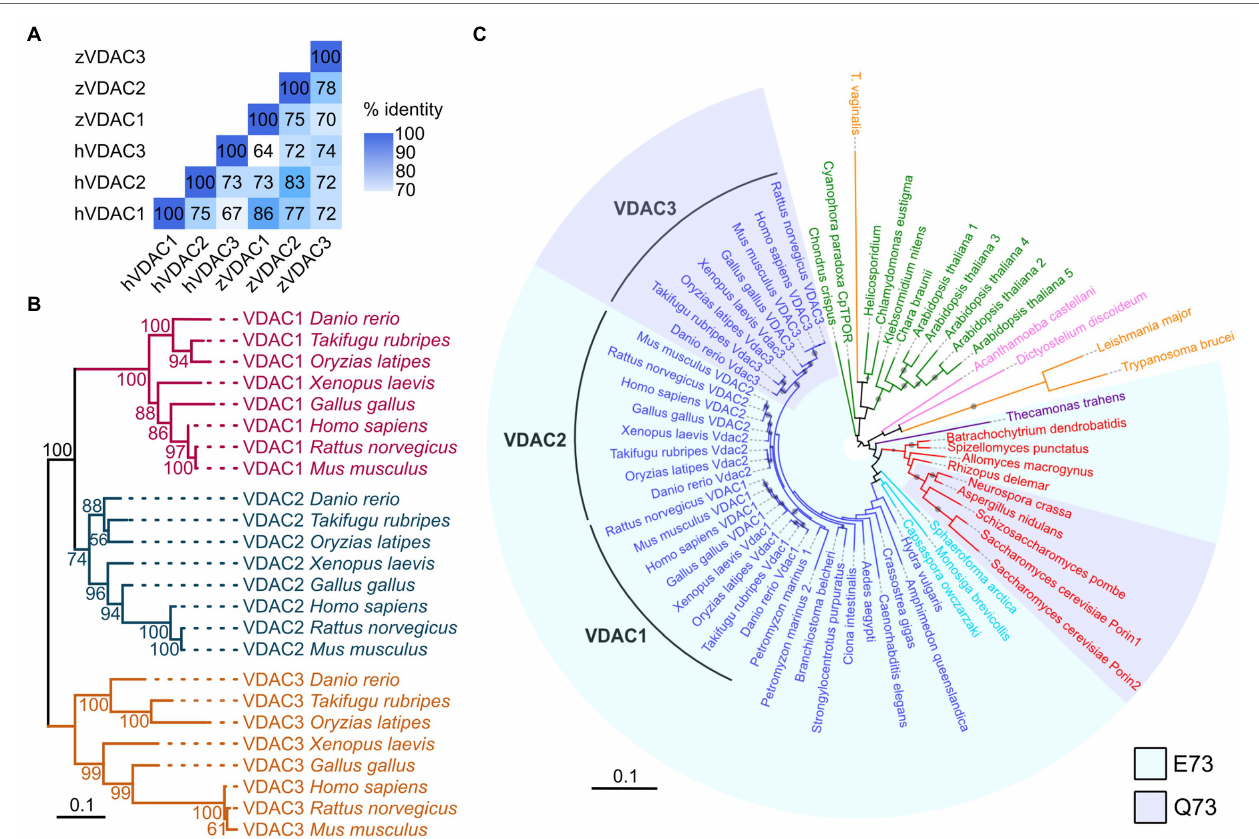
FIGURE 1 | VDACs are highly conserved proteins. (A) Pairwise comparison of sequence identity of human (h) and zebrafish (z) VDAC protein sequences. (B) Maximum likelihood phylogenetic analysis of 24 vertebrate VDAC proteins. Branches are colored based on VDAC gene families (VDAC1: magenta, VDAC2: blue, and VDAC3: gold). Nodes are labeled with bootstrap values in units of percentage. The scale bar for branch lengths indicates the mean number of inferred substitutions per site. (C) Maximum likelihood phylogenetic analysis of 63 VDAC homologs from 41 species. Branches and labels are colored based on phylogenetic groupings of species: blue – animals, light blue – Holozoa (excluding animals), red – fungi, purple – Apusomonadida, orange – Excavata, pink – Amoebozoa, and green – Archaeplastida. Clades are shaded to indicate if proteins contain glutamate (E, light blue) or glutamine (Q, light purple) at amino acid position 73 (with respect to human VDAC1) or are unshaded if this region of the protein lacks high homology with human VDAC1. The size of circles on branches represents bootstrap values and is only displayed for values of 50% and greater. The scale bar for branch lengths indicates the mean number of inferred substitutions per